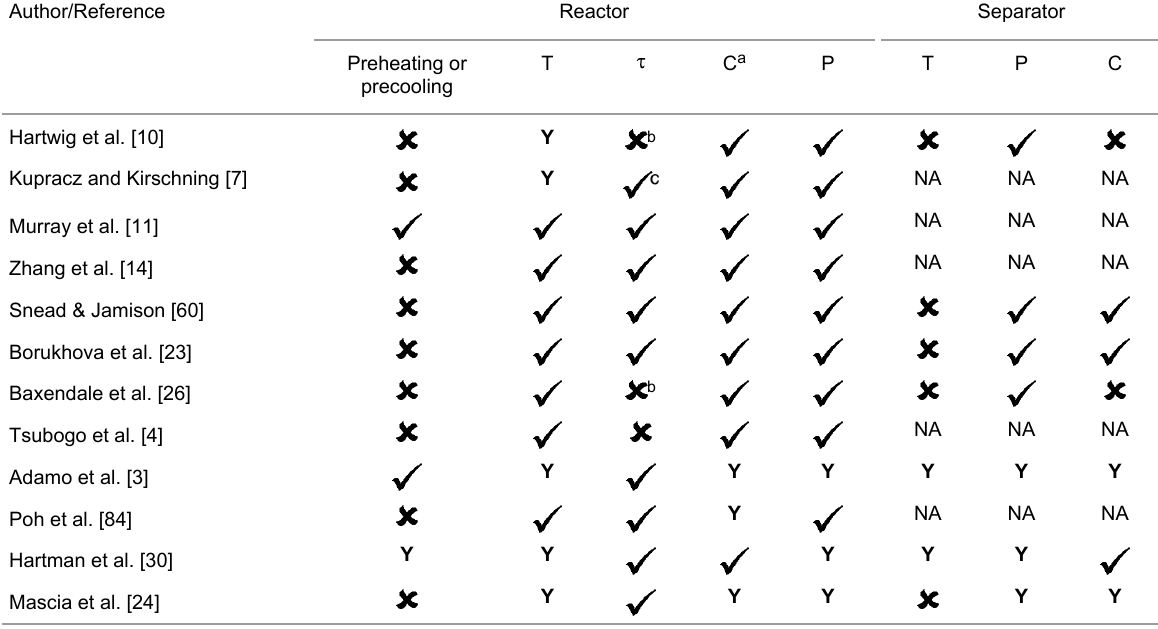
Table 2: Basic variables involved for designing multistep flow synthesis and the status of literature on multistep flow synthesis on adapting suitable automation around these variables.